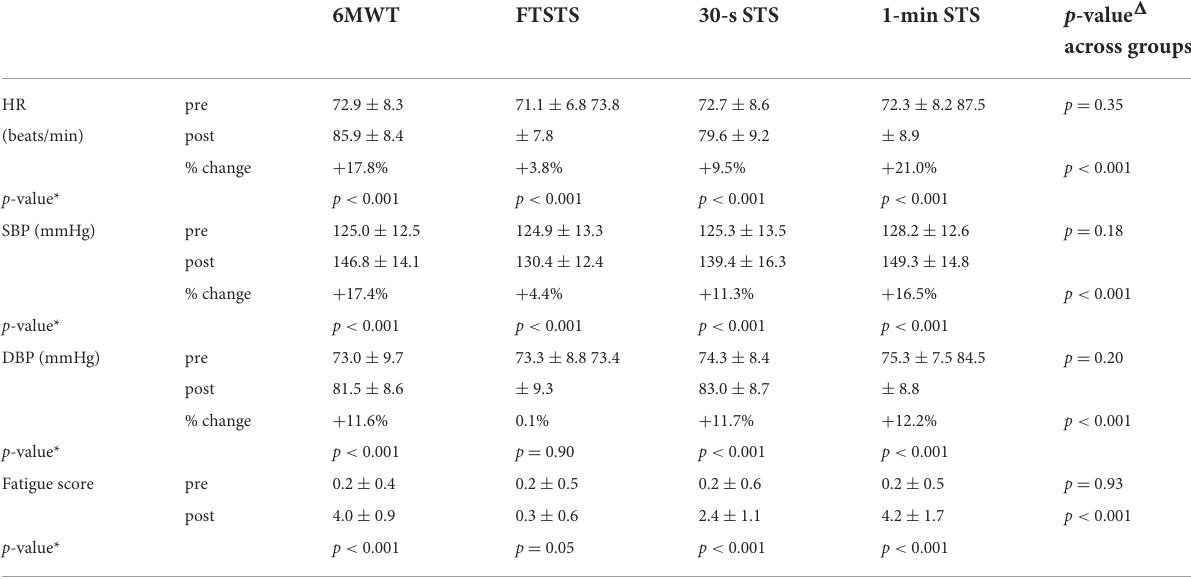
TABLE 2 Hemodynamic data and fatigue score at pre- and immediately post-tests ( n = 112).